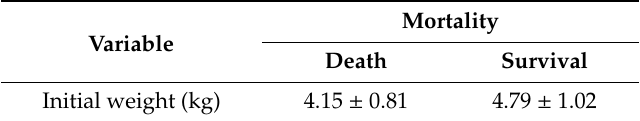
Table 8. Influence of the initial weight on mortality throughout the entire artificial lactation period (one month).